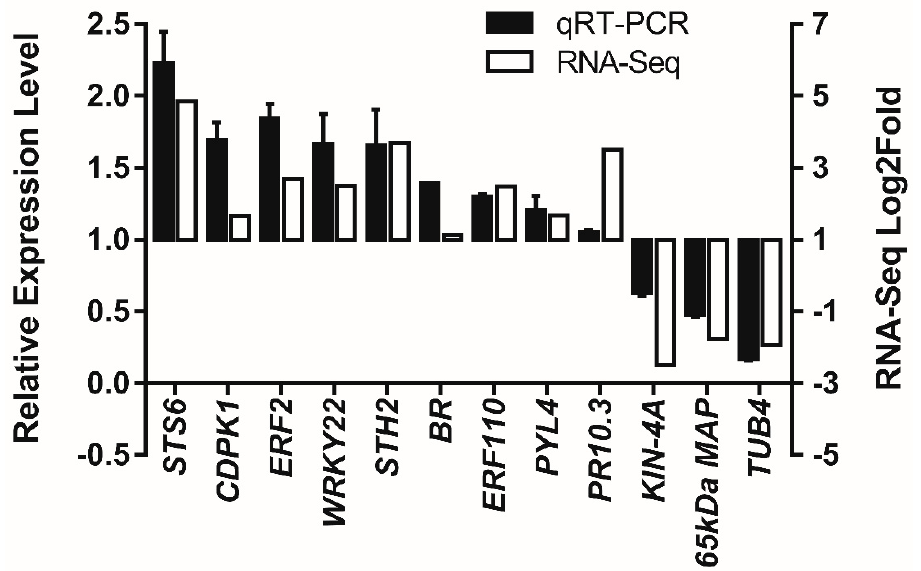
Figure 3. qRT-PCR analysis of relative expression levels of 12 selected DEGs in V. rupestris suspension cells incubated with D. seriata 98.1 and sterile water as the mock-incubated control. Actin was used as the reference gene. The left Y -axis represents the relative expression levels by qRT-PCR (black bar), while the right Y -axis represents the Log2Fold of each selected gene in RNA-seq results (white bar). Mean values and standard errors were obtained from two biological replicates.